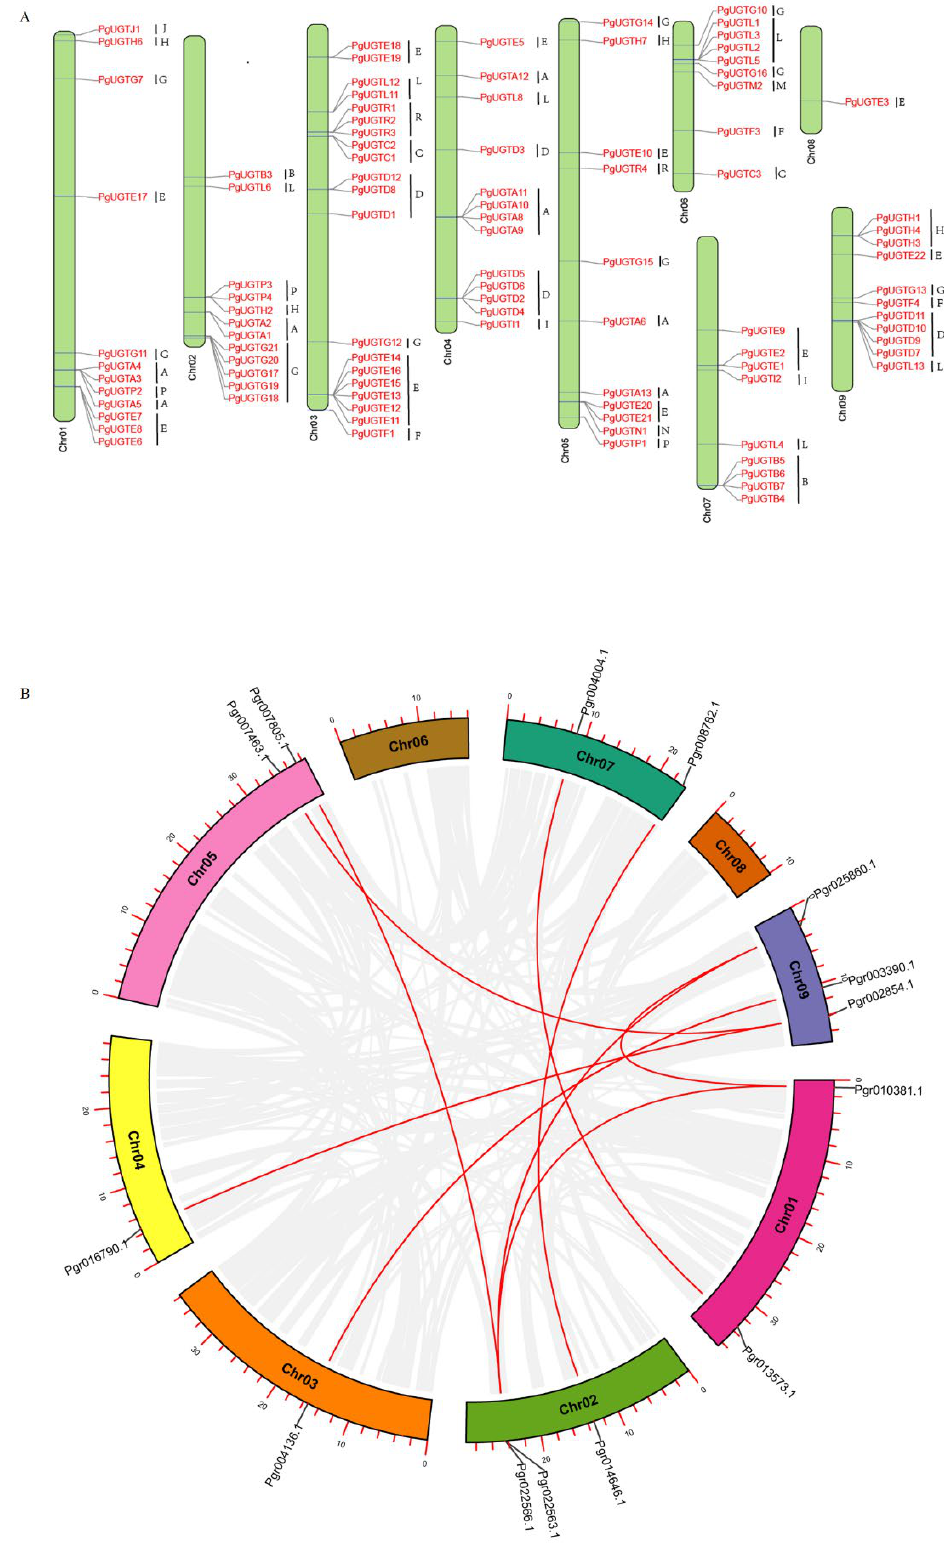
Figure 3. Chromosome distribution and collinearity analysis of PgUGT s. ( A ) The PgUGT s were mapped to different chromosomes. The capital letters (A–J, L–N, P, and R) represent different groups. ( B ) Collinearity analysis of PgUGT s in pomegranate. The red lines highlight the syntenic gene pairs.